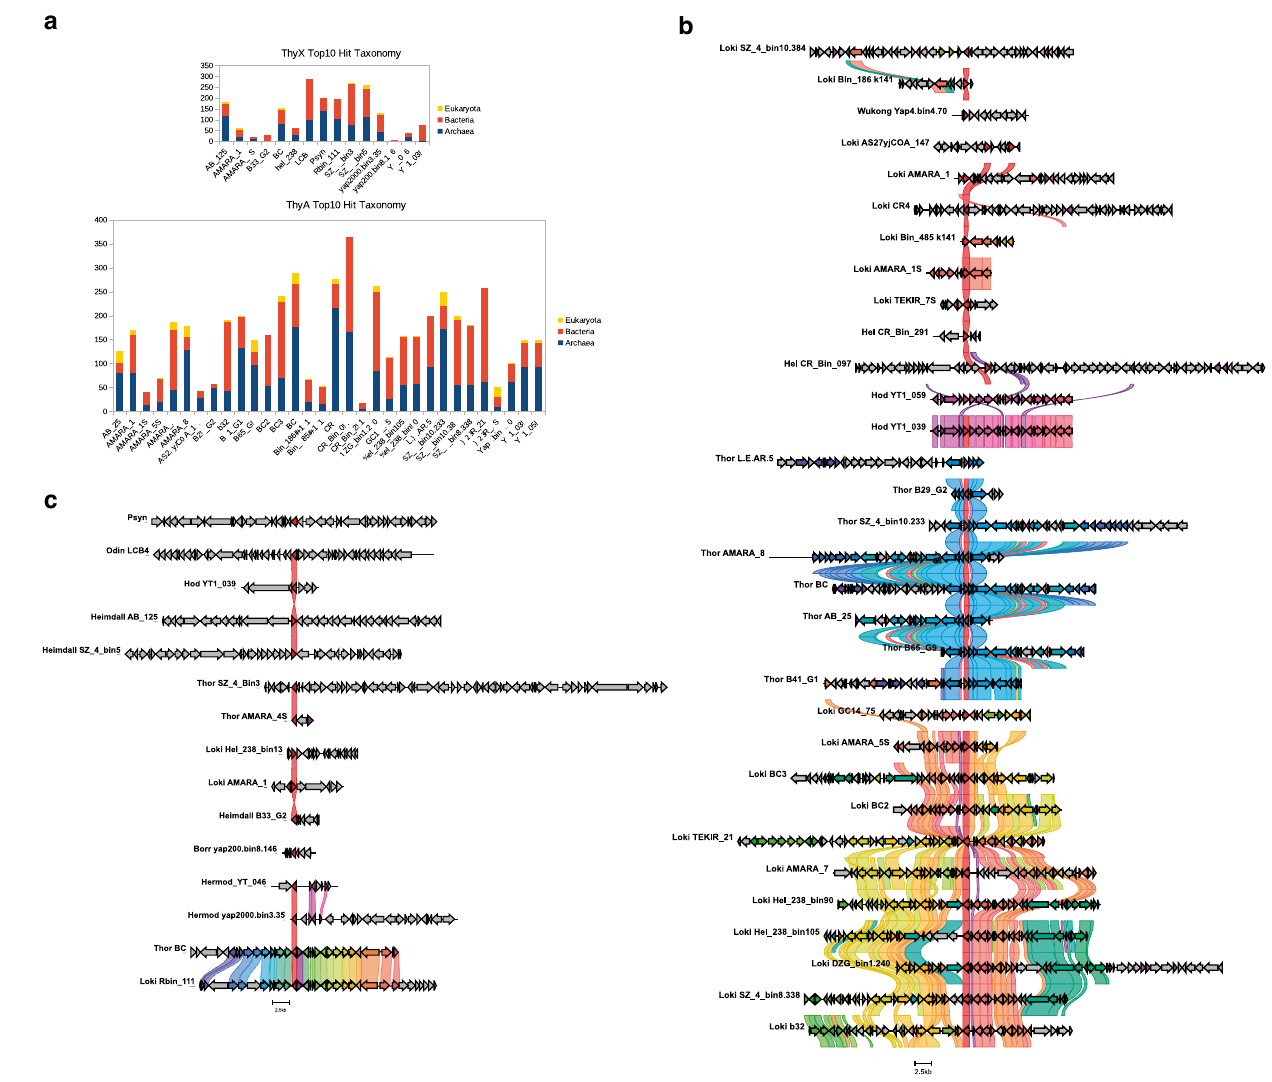
Fig. 5 | Analysis of the genomic environments of Asgard thyX and thyA genes. a TaxonomicoriginoftheneighboringgenesofeachAsgardcontigsencoding thyx or thyA genes. The bar plots indicate the taxonomic origins of the best ten hits against the NCBI RefSeq database of each gene present in the respective contigs. GenesmatchingwithEukaryoticsequenceshavebeenindicatedinyellow,inredfor